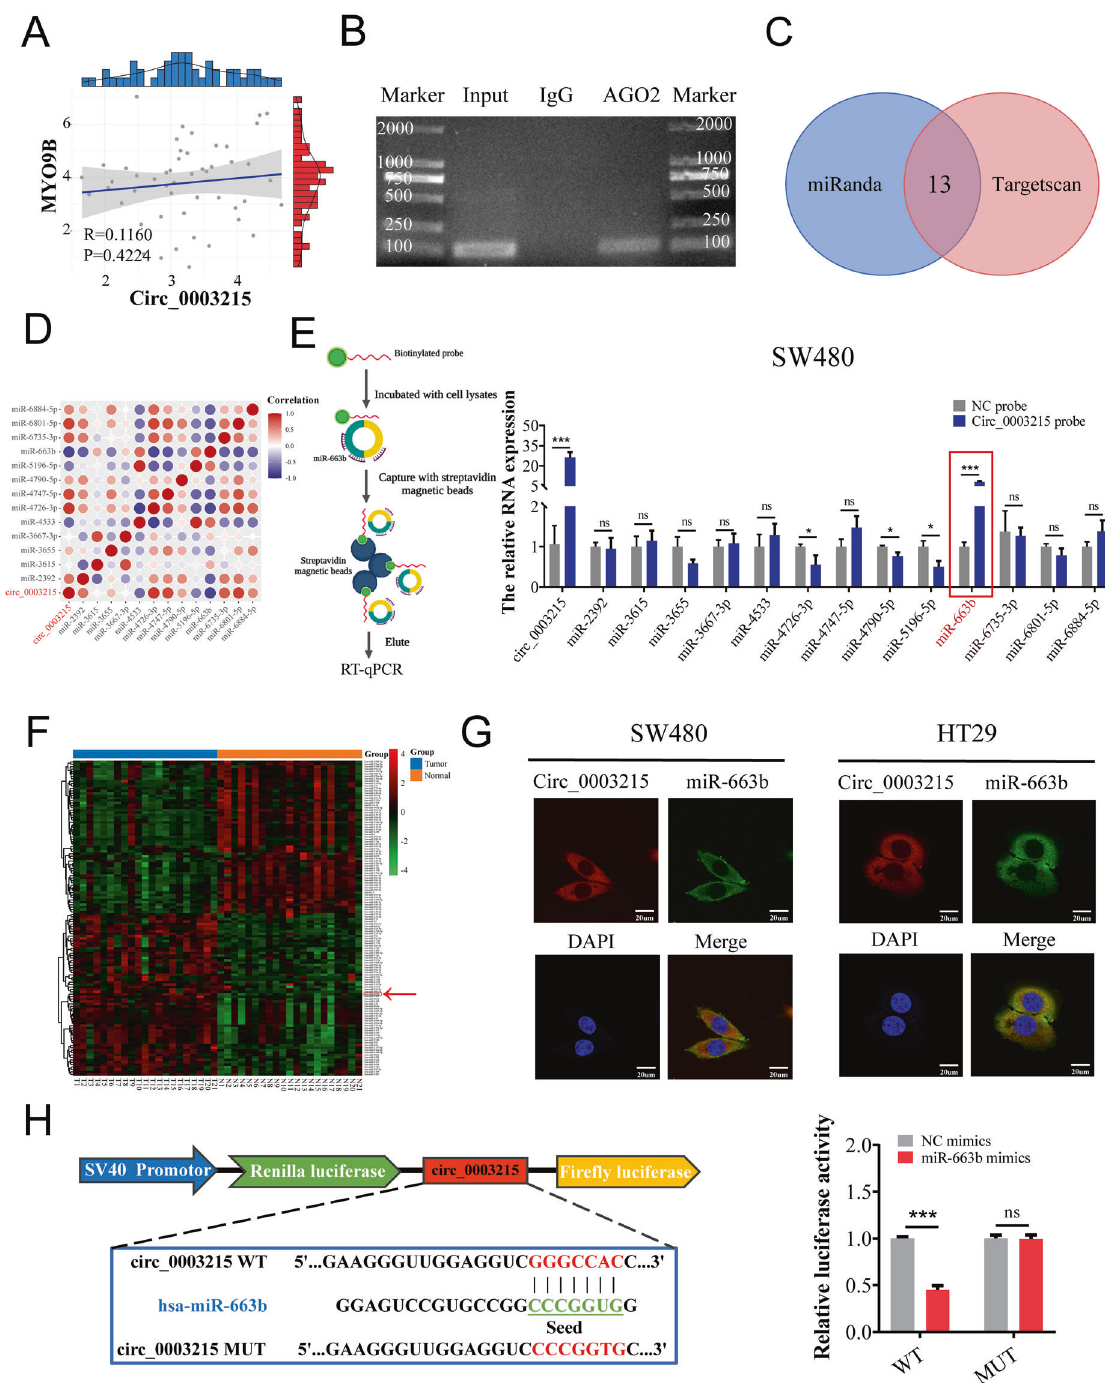
Fig. 4 Circ_0003215 serves as an ef fi cient miR-663b sponge in CRC. A Correlation analysis between the expression levels of circ_0003215 and linear MYO9B using Pearsons correlation coef fi cient. B Circ_0003215 was detected by RIP assay and agarose gel electrophoresis. C The potential target miRNAs of circ_ 0003215 predicted by the circBank tools. D The correlation matrix of circ_ 0003215 and predicated miRNAs levels measured by RT-qPCR in 10 CRC patients. (Red: positive correlation; Blue: negative correlation; circle size and color intensity are proportional to correlation coef fi cients.) E Whole-cell lysates from CRC cells were incubated with biotin-circ_0003215 or NC probe based on the RNA pull-down fl ow diagram(left), and the enrichment levels of circ_0003215 and predicated miRNAs were analyzed by RT-qPCR in SW480 cells(right). F The heatmap of miRNA sequencing data of 21 pairs of CRC tissues (GSE89143). G FISH asssay showed the colocalization between circ_0003215 and miR-663b in SW480 and HT29 cells. H The structure and the sequence of circ_0003215-WT or circ_0003215- MUT luciferase plasmid(left). The relative luciferase activities of HEK-293T co-transfected with miR-663b mimics and circ_0003215-WT compared to circ_0003215-MUT (right). * P < 0.05, ** P < 0.01, *** P < 0.001.